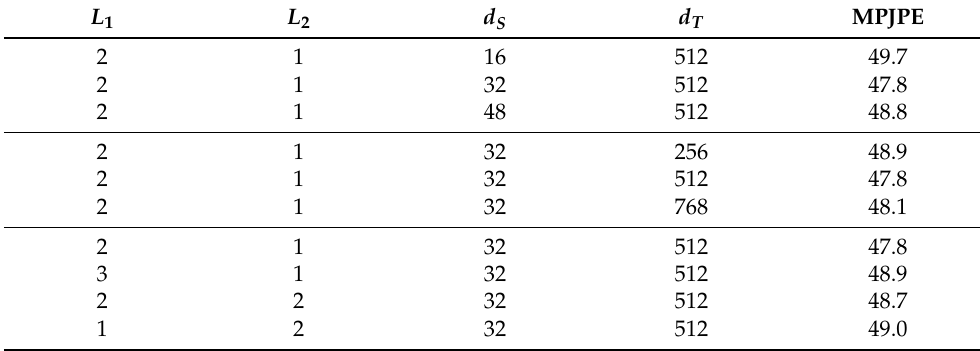
Table 6. Ablation experiments for different parameter settings of our model.